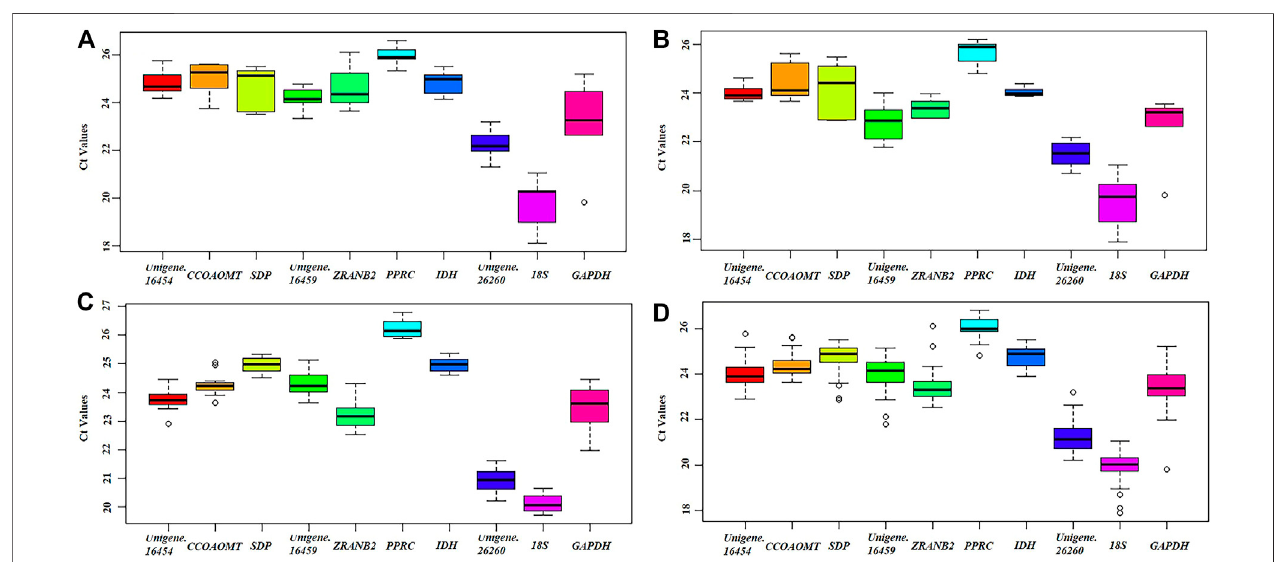
Frontiers in Genetics |